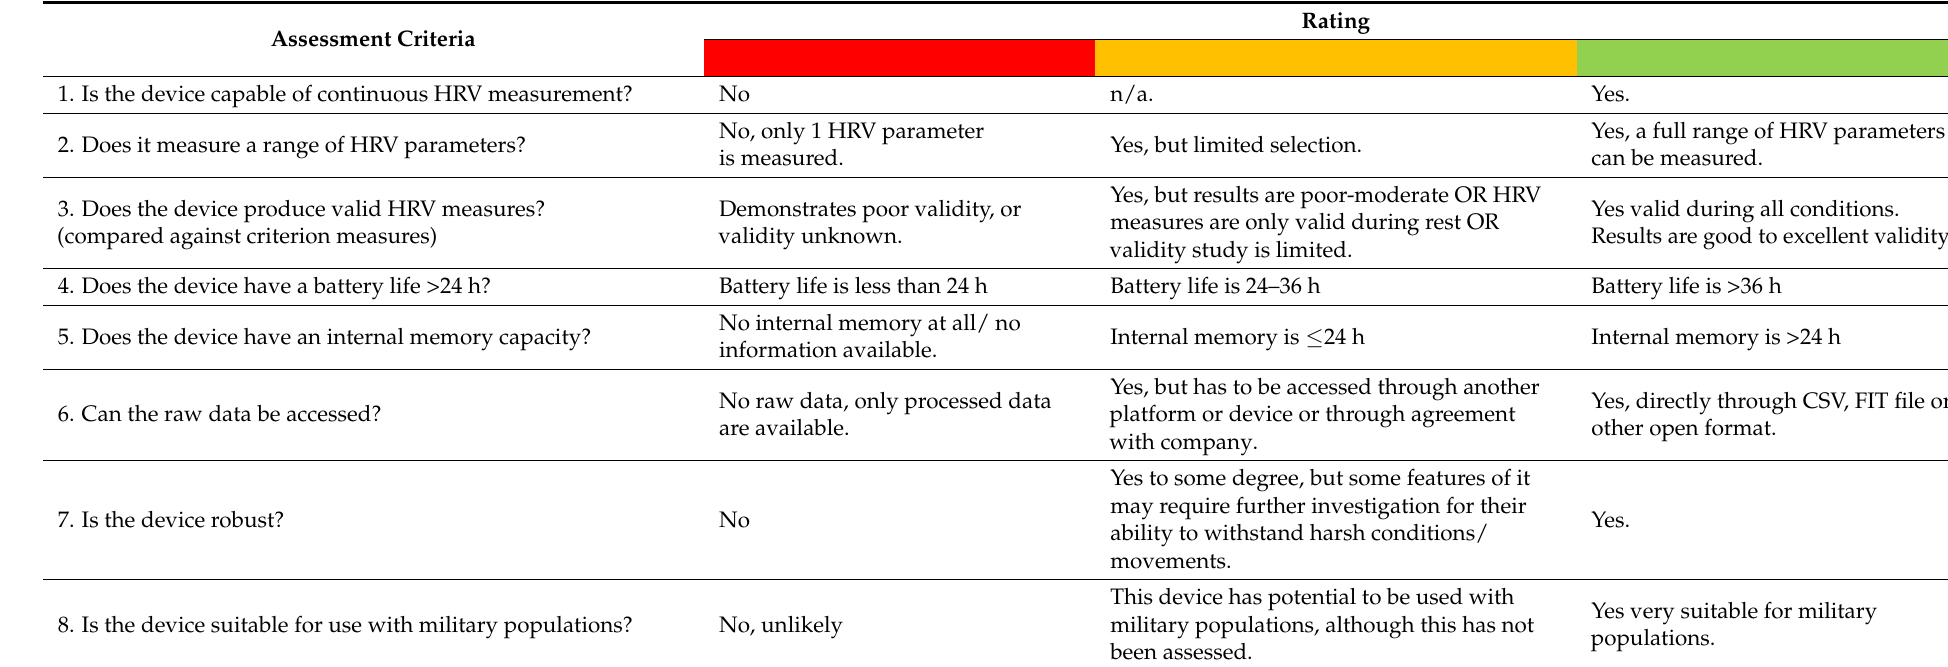
Table 1. Criteria used to assess wearable devices based on the peer-reviewed literature and manufacturer’s